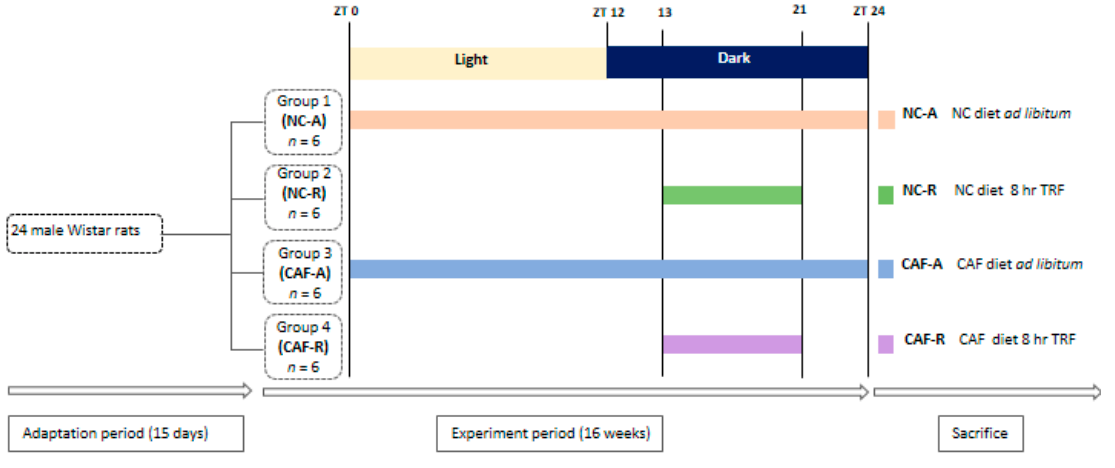
Figure 1. Schematic representation of the experimental feeding schedule. Male Wistar rats were allowed a 15-dayadaptationperiod prior to beginning the experiment and were divided into four groups as follows: NC–A (normal chow, ad libfeeding); NC–R (normal chow time, restricted feeding); CAF–A (cafeteria diet, ad libfeeding); and CAF–R (cafeteria diet, time-restricted feeding). Time-restricted feeding groups were allowed to feed for 8 h per day during the dark phase between ZT 13 and ZT 21. After sixteen weeks of experiment, animals were sacrificed. CAF: cafeteria diet; NC: normal chow diet; TRF: time-restricted feeding; ZT: Zeitgeber.